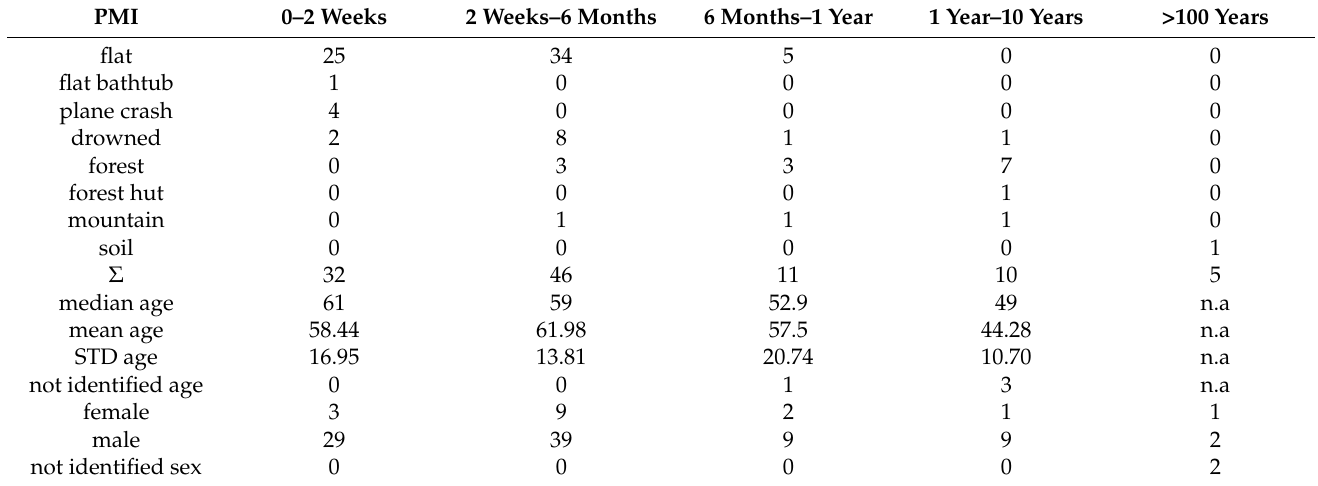
Table 1. Anthropological properties and discovery of the measured human skeletal remains.